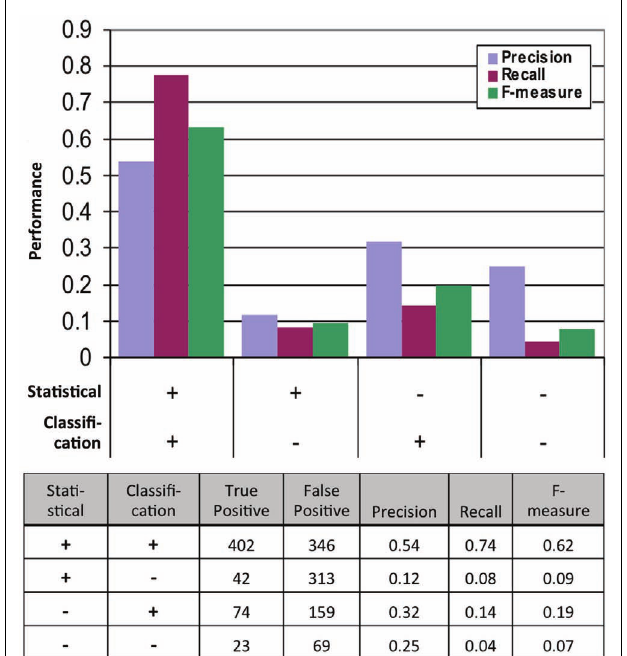
FIGURE 2 | Performance of the statistical and classification methods measured by the results of the second, much more rigorous mbSUS assays. TP, true positive (positive in the second mbSUS) and FP, false positive (negative in the second